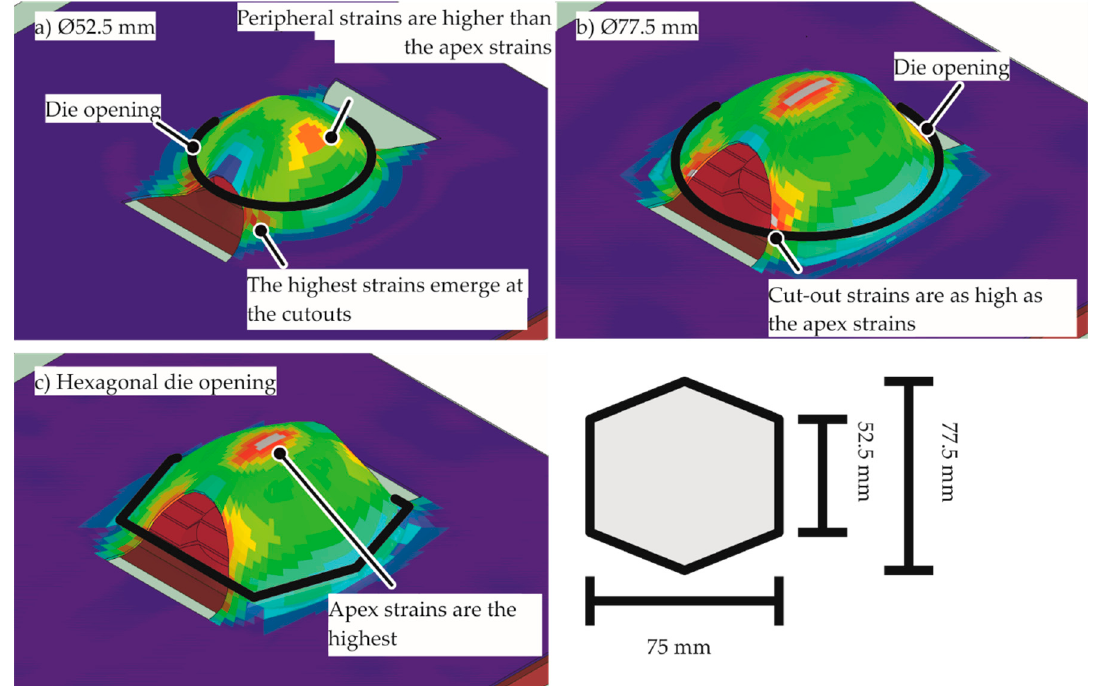
Figure 8. Simulation result with the plane strain specimen. The red contour indicates the highest equivalent plastic strain ( a ) with the standard Ø52.5 mm die opening, ( b ) with a Ø77.5 mm die opening, ( c ) with an optimized hexagonal die opening.